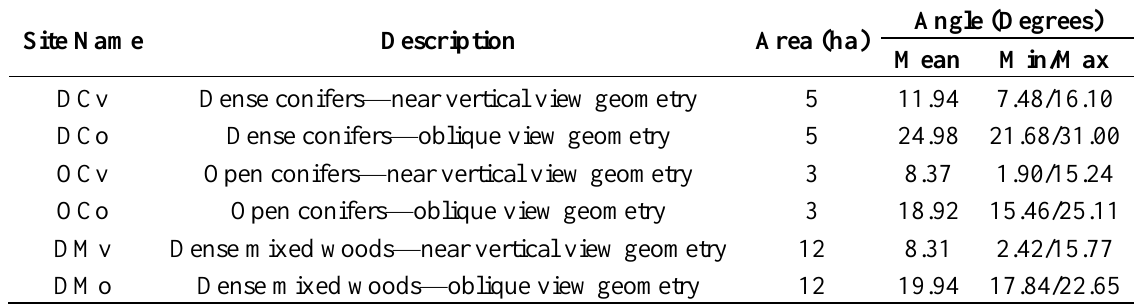
Table 1. Description of the six study sites with their approximate coverage and view angles.